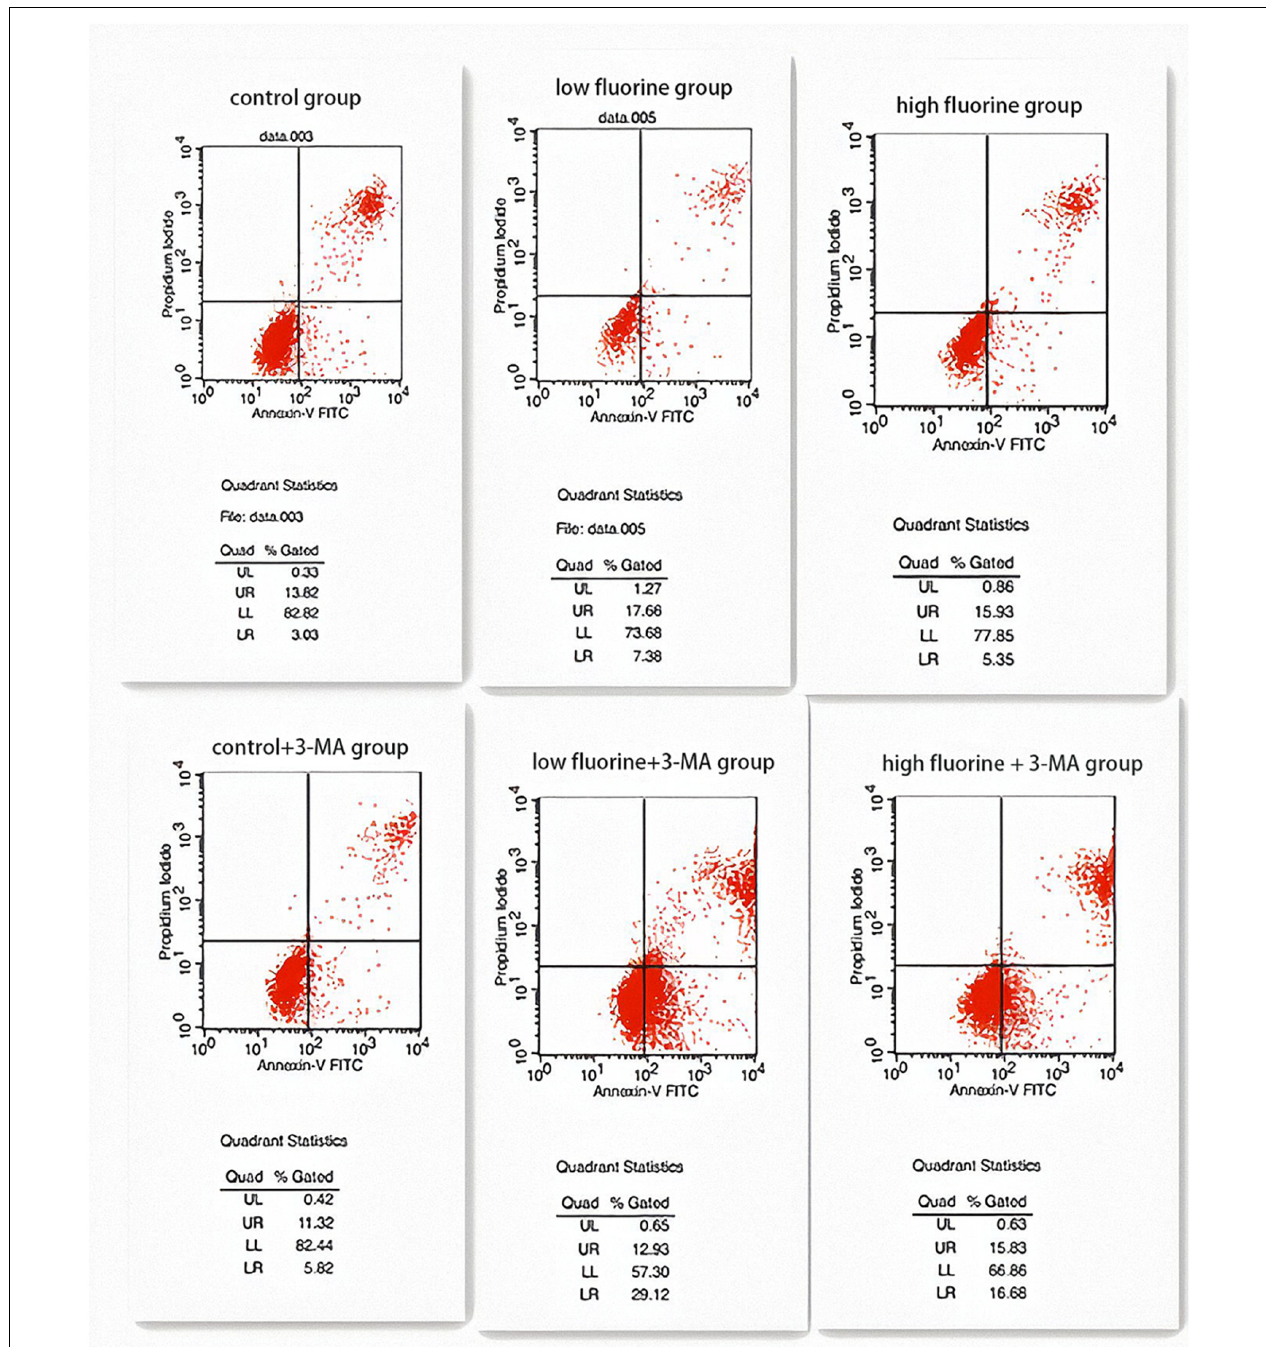
FIGURE 4 | Apoptosis of cultured osteoblasts. The apoptosis rates of the following groups of osteoblasts were detected by flow cytometry: control group; low-fluoride (2.5 mg/L) group; high-fluoride (5 mg/L) group; control + 3-MA (10 mmol/L) group; low-fluoride (2.5 mg/L) + 3-MA (10 mmol/L) group; high-fluoride (5 mg/L) + 3-MA (10 mmol/L)